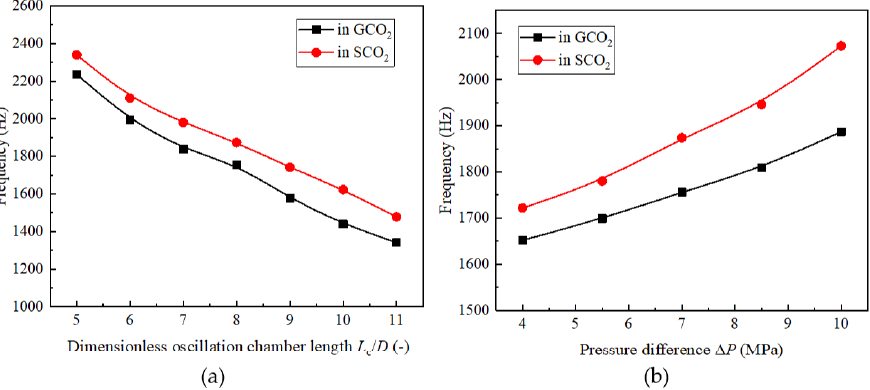
Figure 10. Variations of dominant oscillation frequency: ( a ) with the chamber length and ( b ) with the pressure difference. Experimental conditions: ∆ P = 4–10 MPa, 5 ≤ L c / D ≤ 11, and P a = 6 or 8.5